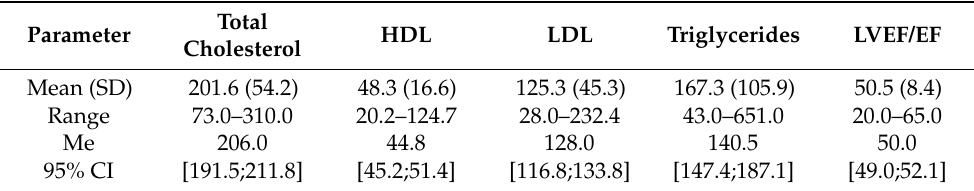
Table 3. Characteristics of the study group in terms of total cholesterol (mg/dL), HDL, LDL, triglyc- erides (mg/dL), and